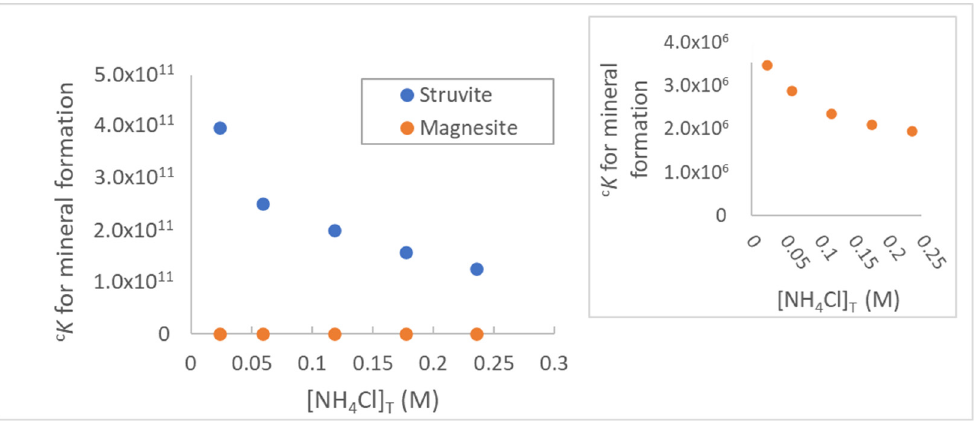
Figure 4. Conditional equilibrium constants ( c K values) calculated by MINEQL+ versus [NH 4 Cl] T .